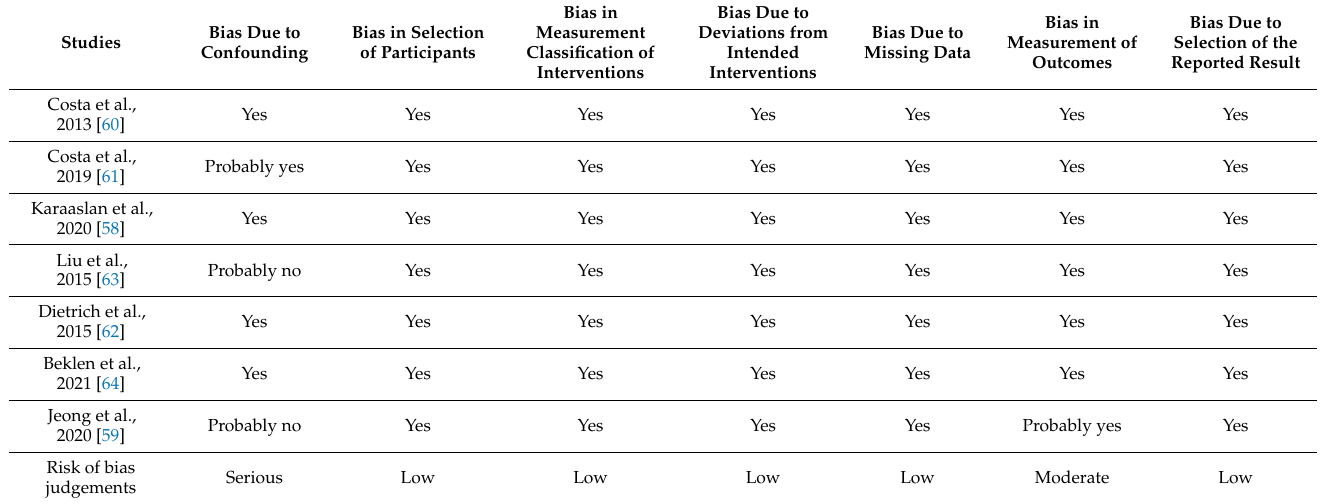
Table 4. Risk of bias for the studies included in the systematic review: ‘Yes’ indicating a low risk of bias, ‘Probably yes’ indicating a moderate risk of bias, ‘Probably no’ indicating a serious risk of bias, ‘No’ indicating a critical risk of bias, and ‘No information’ indicating that no information was